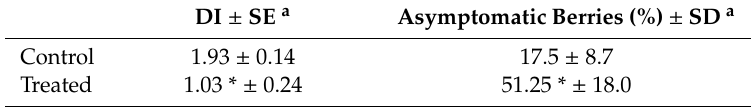
Table 3. Protection of grape berries from B. cinerea infection by treatment with 4 at 50 µ M.